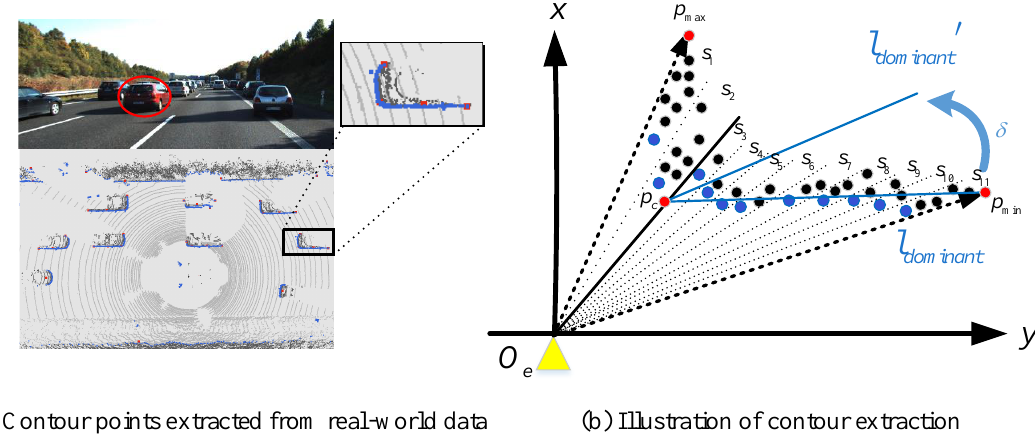
Figure 5. Schematic illustration for optimal contour extraction. The red dot represents the corner point, and the blue dots represent the contours in each segment, and the dashed lines divide the points on the target into different